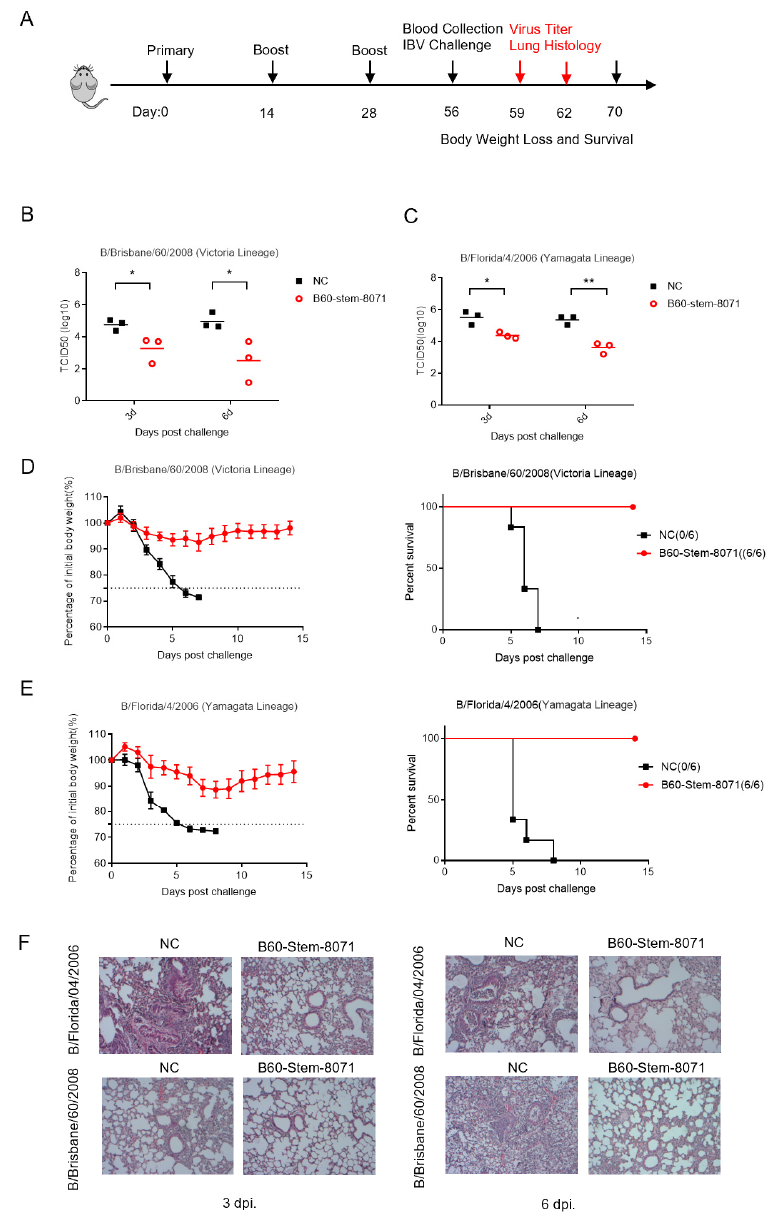
Figure 5. B60-Stem-8071 conferred robust broad protection against cross-lineage IBV infection in vivo. ( A ) Diagram showed experimental plan. Twelve mice per group vaccinated with B60-Stem-8071 or adjuvant (NC group) were infected with B/Brisbane/60/2008(Victoria lineage) or B/Florida/4/2006(Yamagata lineage) intranasally. Three mice per group were euthanized on the